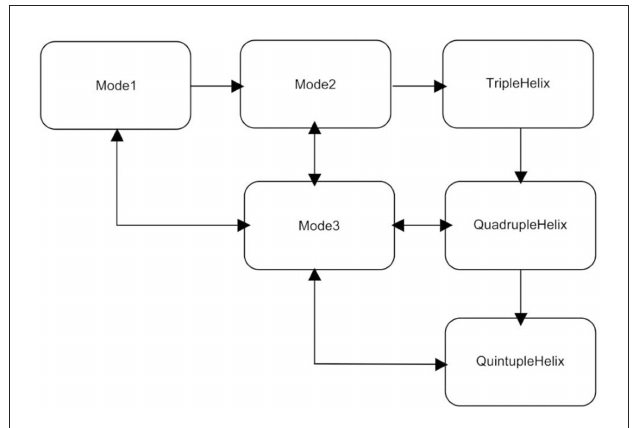
FIGURE2 The evolution of the models of knowledge creation. Source: Carayannis et al. (2012).